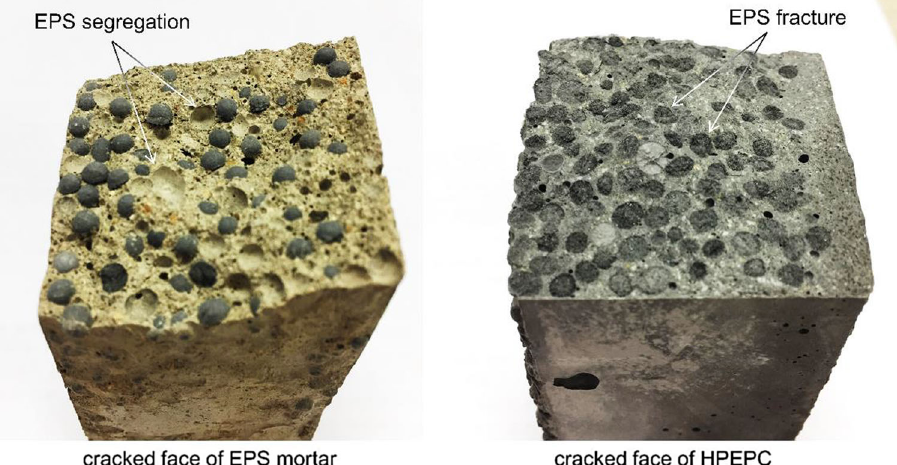
Fig. 5 Comparison of cracked face in EPS mortar and HPEPC specimens.